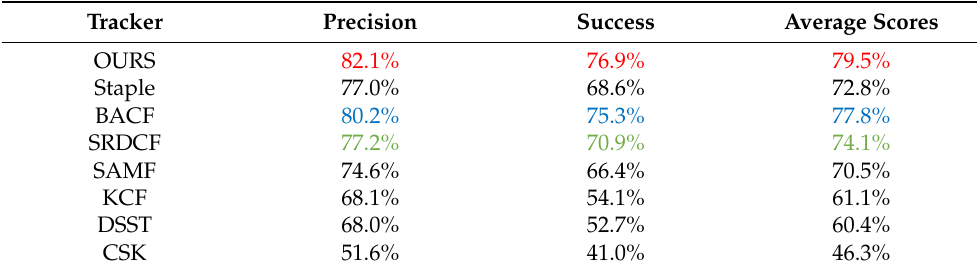
Figure 3. Precision plot and success plot of the eight algorithms on the OTB-2015 dataset. Table 2. Average performance of algorithms on the OTB-2015 dataset.